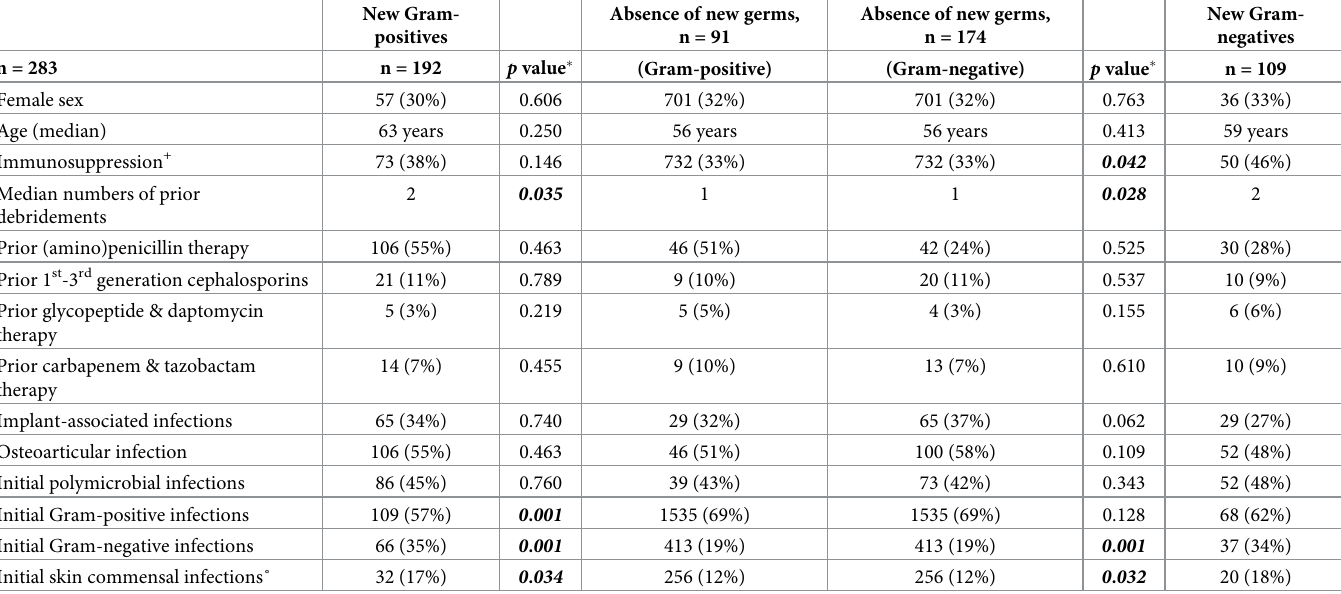
Table 2. Characteristics of resistant pathogens in repetitive intraoperative samples performed under current antibiotic therapy (Some episodes have mixed new Gram-positive and Gram-negative infections , which we display separately in both lateral columns) .